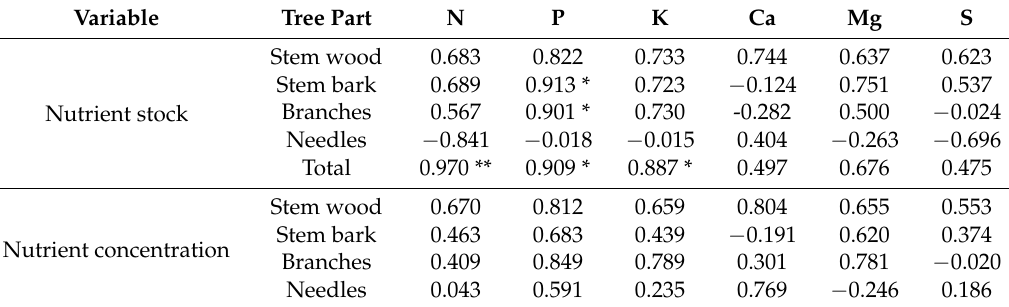
Table 5. Pearson’s correlation coefficients ( r ) between stand density and nutrient stock and between stand density and nutrient concentration in different tree parts of the sampled Scots pine